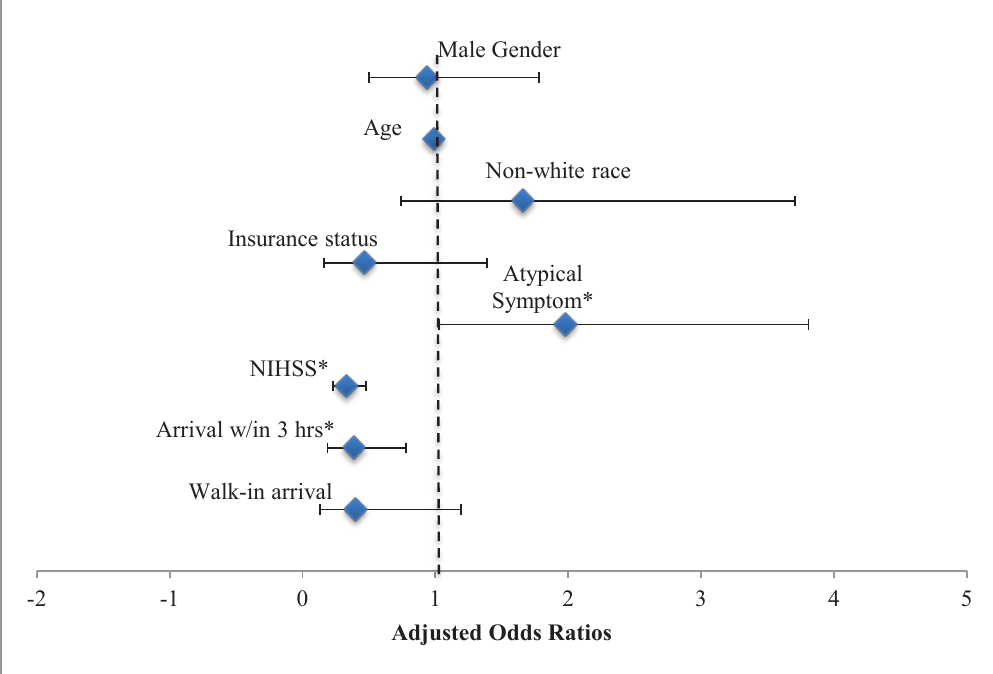
Figure 1. Adjusted odds of triage to non-critical care beds are displayed. NIHSS, National Institute of Health Stroke Scale Predictors are male gender, age, non-white race, insurance status, presence of atypical symptom (*p=0.04), NIHSS score as a continuous variable transformed using square root (*p<0.001), walk-in arrival compared to ambulance arrival, and arrival within 3 hours of symptom onset (*p=0.008). Model fit was tested using Hosmer–Lemeshow goodness-of-fit test, (χ 2 =7.87, p=0.45).